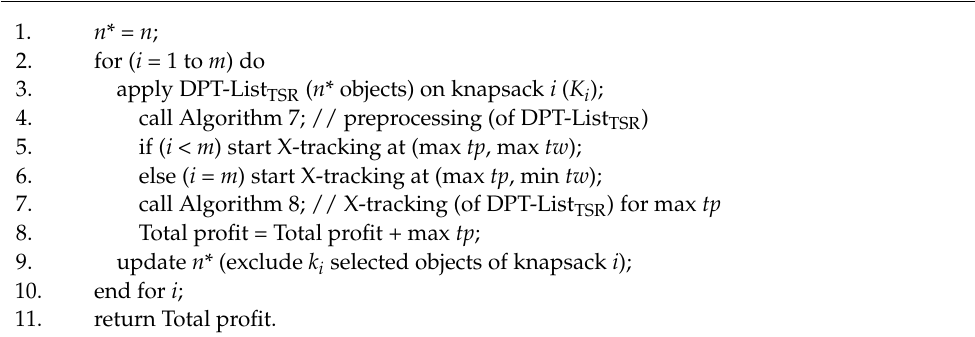
Algorithm 9: Multi-DPT-List TSR for one proper order: O( m [ n 2 , nC ]).